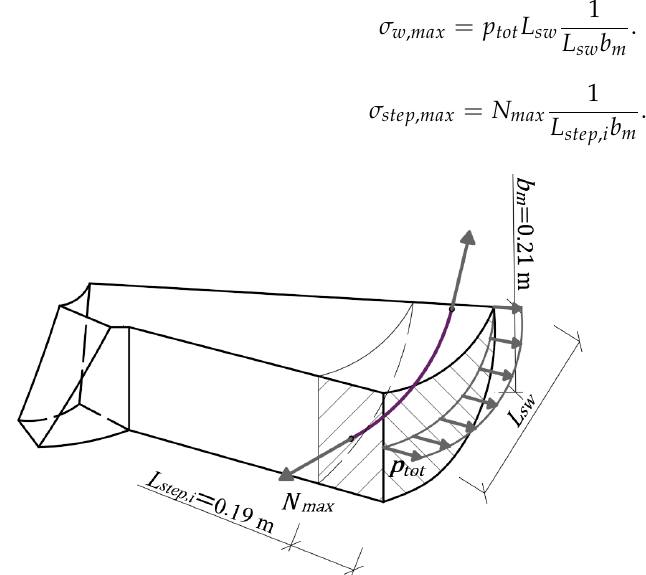
Figure 7. Perspective view of a typical step with line 4